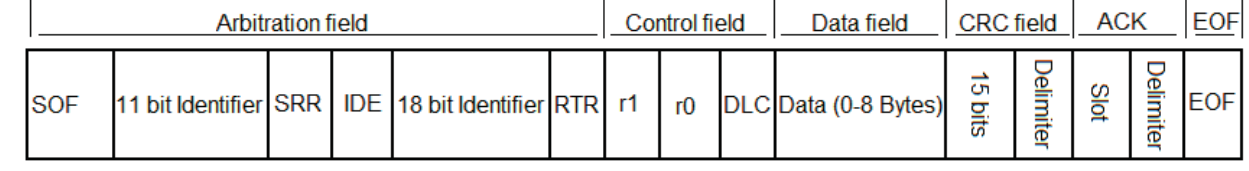
Figure 1. Data frame of CAN 2.0